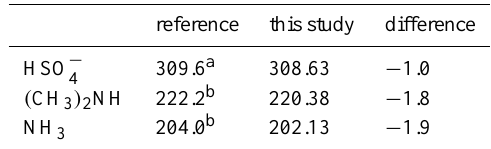
Comparison of computational